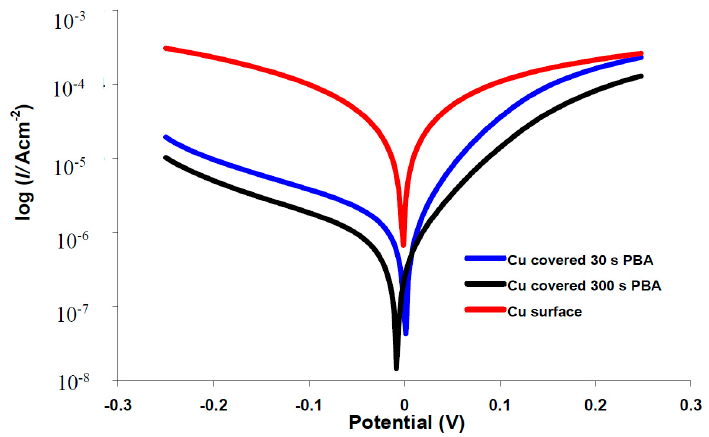
Figure 4. Typical polarization curves for corrosion in citrate buffer, pH3 of copper electrode ( ─ ), covered with 4-phenylbutyric acid (PBA): 30 s ( ─ ) and 300 s ( ─ ).